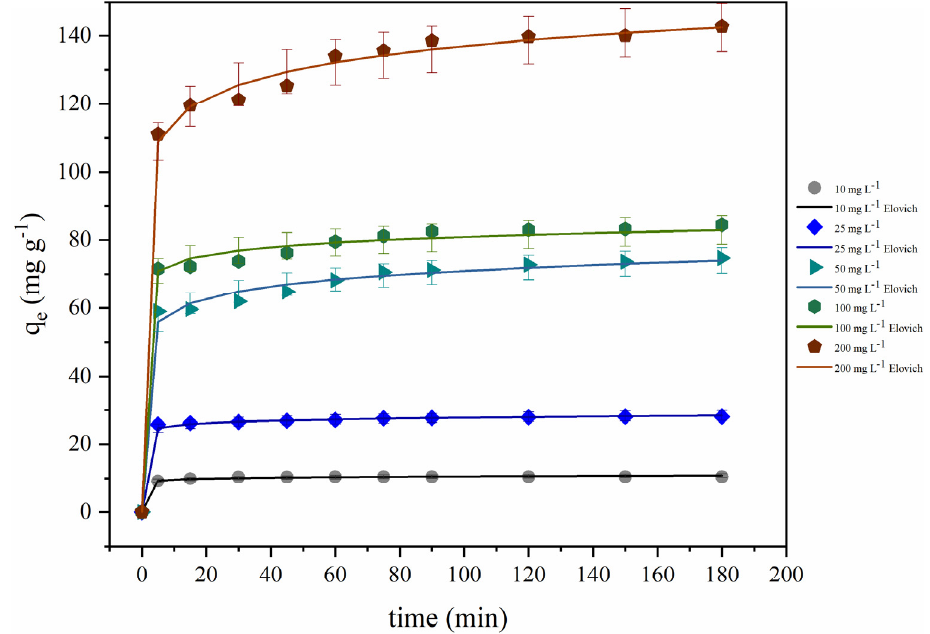
Figure 13. Kinetic curves for TC adsorption on CS · Fe 3 O 4 Figure 13 . Kinetic curves for TC adsorption on CS·Fe 3 O 4 .